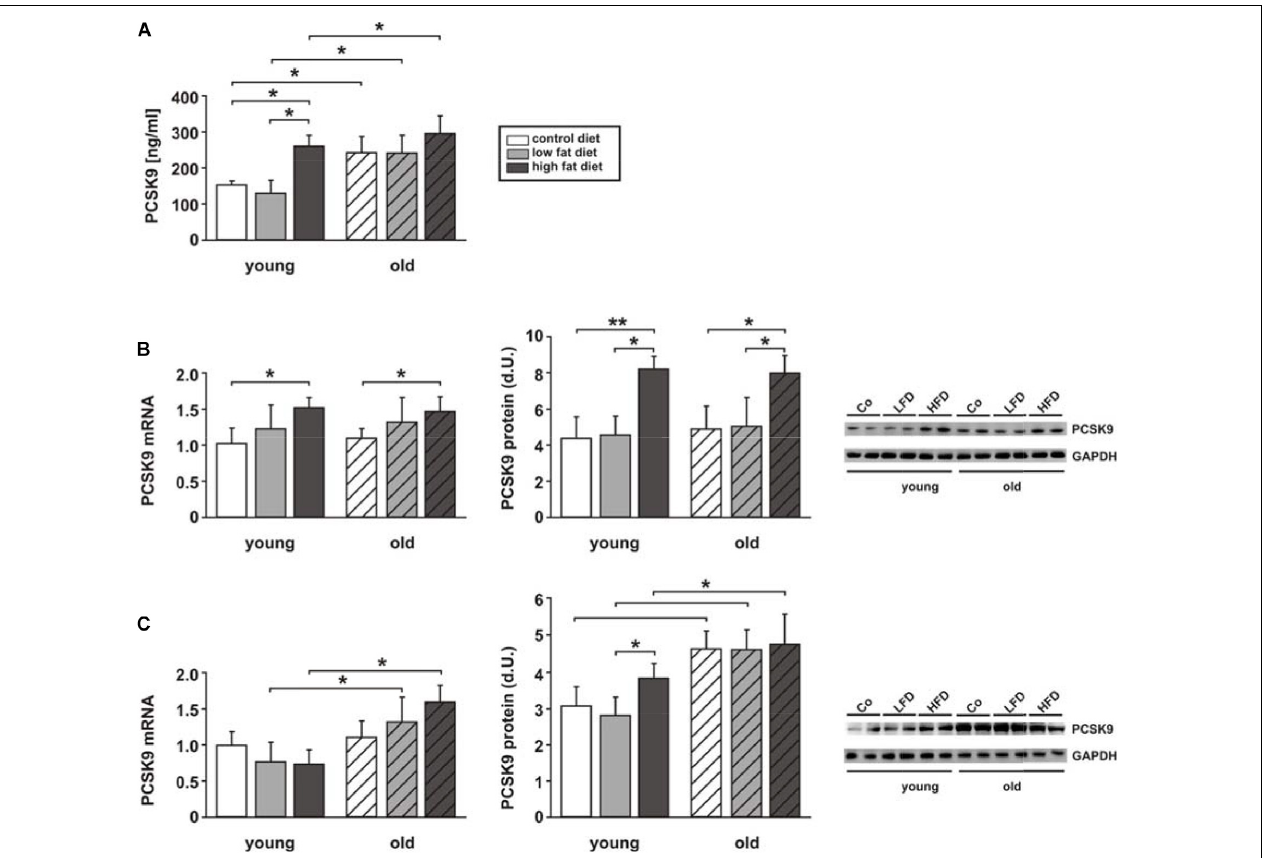
FIGURE 3 | Impact of diet-induced obesity on PCSK9 release and expression. Measurements were performed in samples of young and old mice receiving control diet, low fat diet (LFD) or high fat diet (HFD) for 16 weeks. (A) Plasma PCSK9 was measured by ELISA at the end of the study. (B) Results from qPCR analyses on PCSK9 mRNA expression, densitometry of PCSK9 protein expression and representative Western blots from liver tissue. (C) Results from qPCR analyses on PCSK9 mRNA expression, densitometry of PCSK9 protein expression and representative Western blots from adipose tissue. All data are mean ± SEM. * p < 0.05, ** p < 0.01. n = 14 animals per